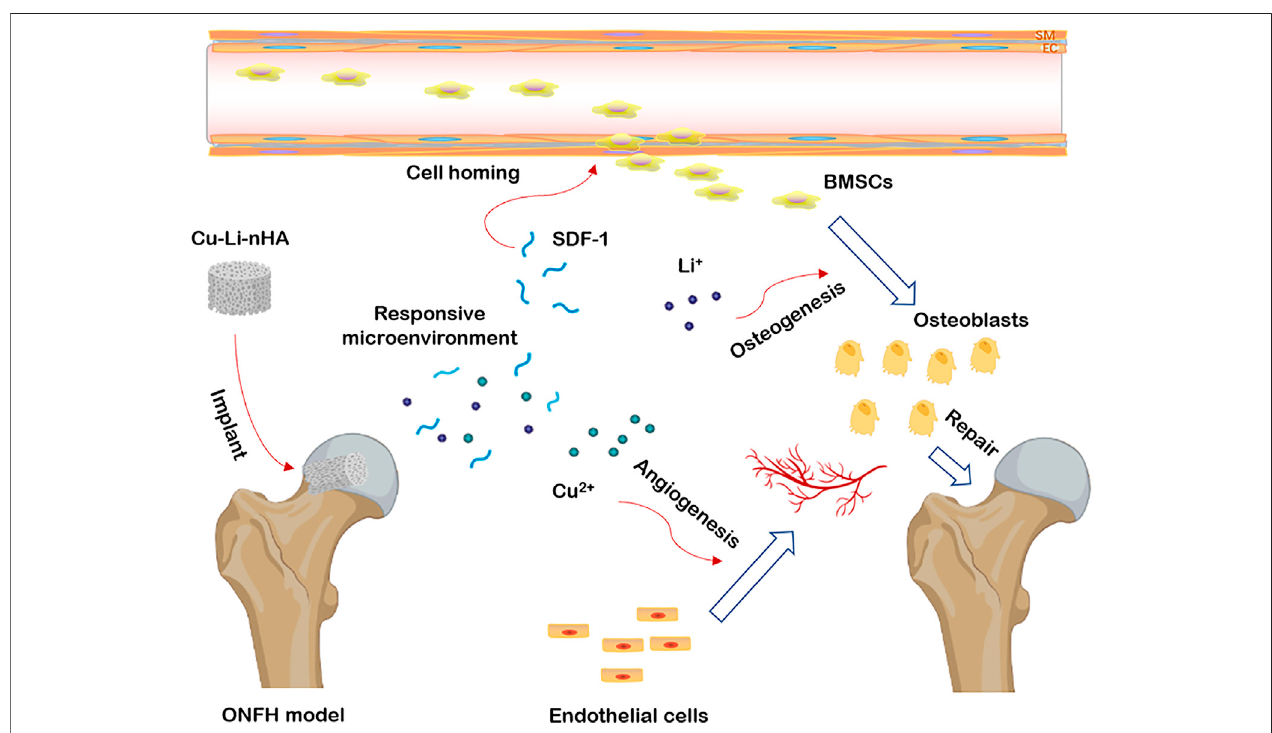
FIGURE1| Thegraphicalabstractofthestudy.Cu-Li-nHAimplantationcouldstimulateadjacenttissueandbuildanoptimalmicroenvironment via releasingLi + and Cu 2+ , and promote cell homing, osteogenesis and angiogenesis to repair ONFH.